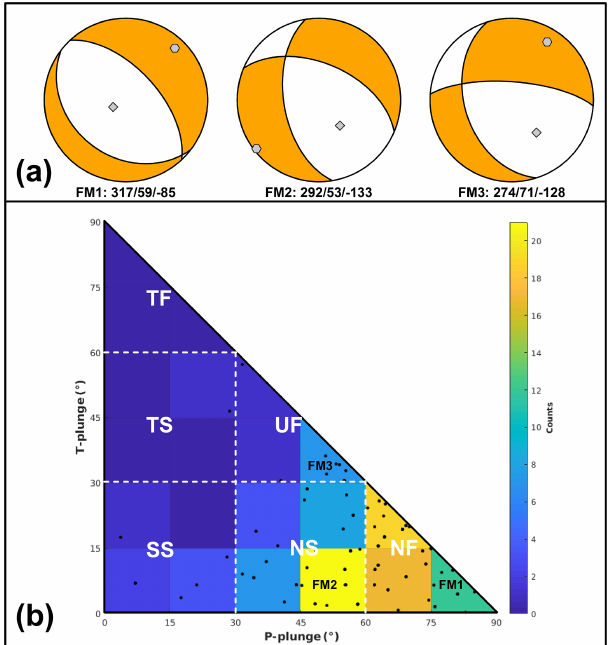
Figure 2. Fault plane solutions used for earthquake simulations. (a) From left to right: (1) M s 6.9, 23 November 1980 (FM1); (2) and (3) median focal mechanism found from solutions of the first (FM2) and fifth (FM3) most populated bin of histogram of panel (b) . (b) Fault plane solutions (black dots) are classified according to the plunge of P- and T axes with the specific tectonic regimes (leg- end: NF, normal fault; NS, normal strike; SS, strike-slip; TF, thrust; TS, thrust-strike; UF, unknown fault). The number of earthquakes (colour bar) is counted in bins of 15 ◦ × 15 ◦